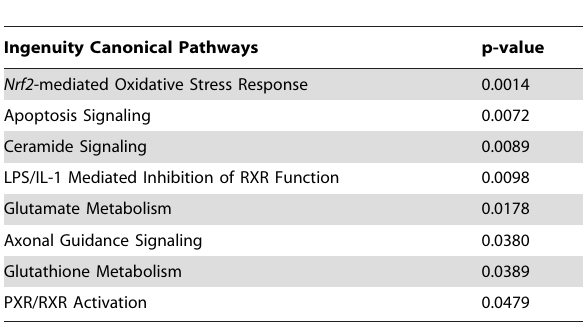
Table 3. Pathway analysis of gene expression in morphologically normal prostate tissue in men who took lycopene supplements for three months (n=29) compared with placebo